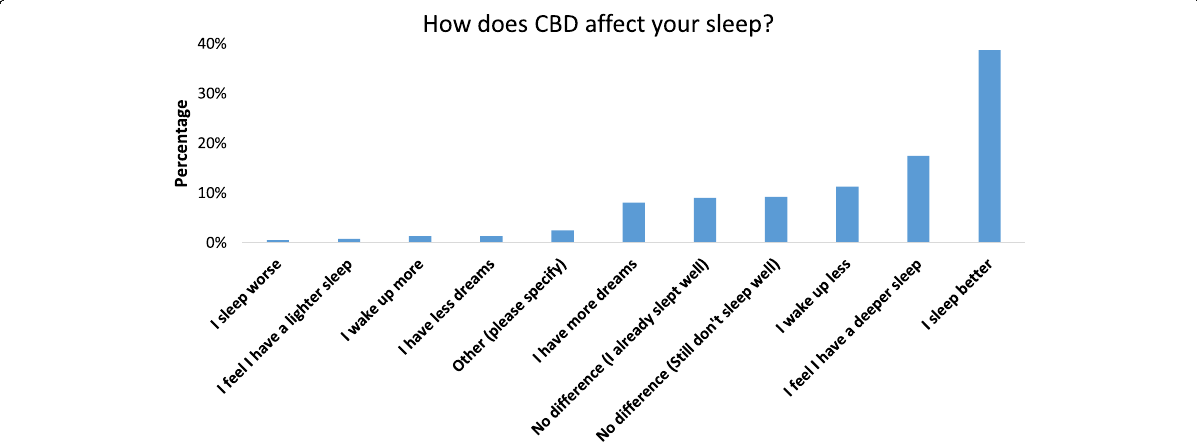
Fig. 2 Perceived effects of cannabidiol on sleep amongst adult cannabidiol users responding to the question “ how does cannabidiol affect your sleep? ” Participants were allowed to select multiple options. Y -axis represents percentage of total responses ( n =